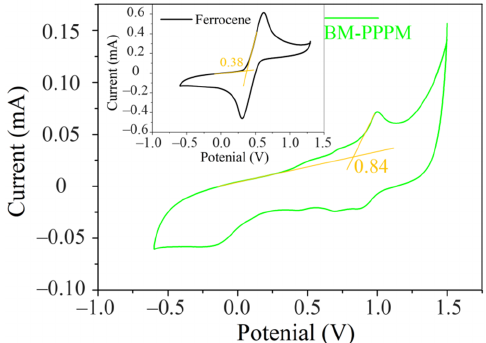
Figure 5. Cyclic voltammetry experiments of molecule BM-PPPM-C6 and ferrocene at a concentration of 1 × 10 − 3 mol/L in DCM.